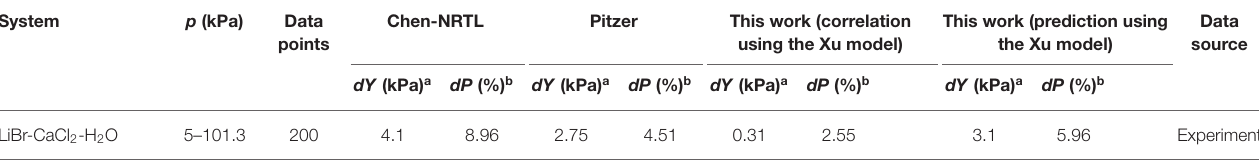
TABLE 9 | Comparison of models for the electrolyte solutions. System p (kPa) Data